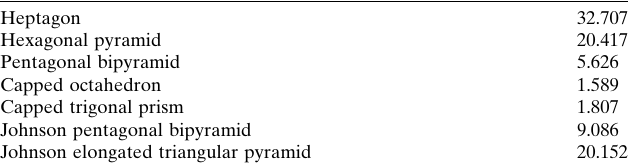
Table 3 Continuous shape measurement (CShM) values ( SHAPE 2.1 ) for the five-coordinate manganese ion of 1 .